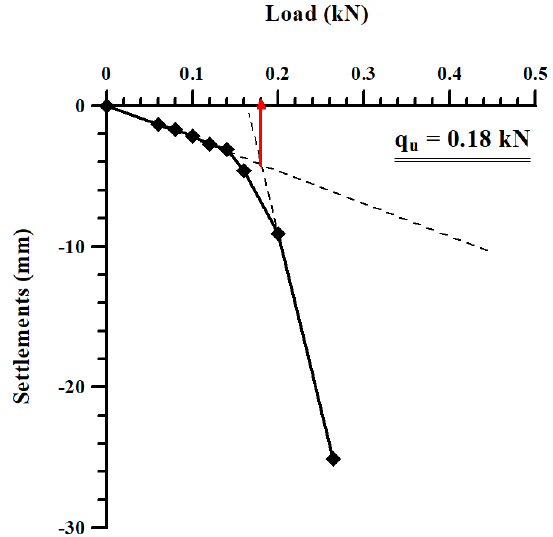
Figure 10. P-S curve for model test. q u : ultimate load.